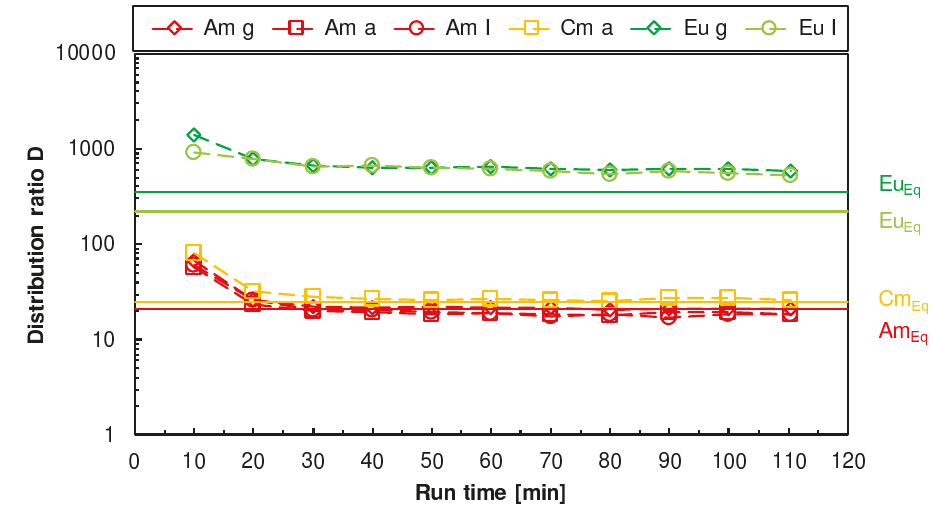
Figure 3. Am, Cm, and Eu distribution ratios as a function of the experimental run time (data points) and equilibrium values (horizontal lines) in the Scrub 2 section single centrifugal contactor test. “g”, “a”, and “I” indicate values measured by gamma and alpha spectrometry as well as ICP-MS,